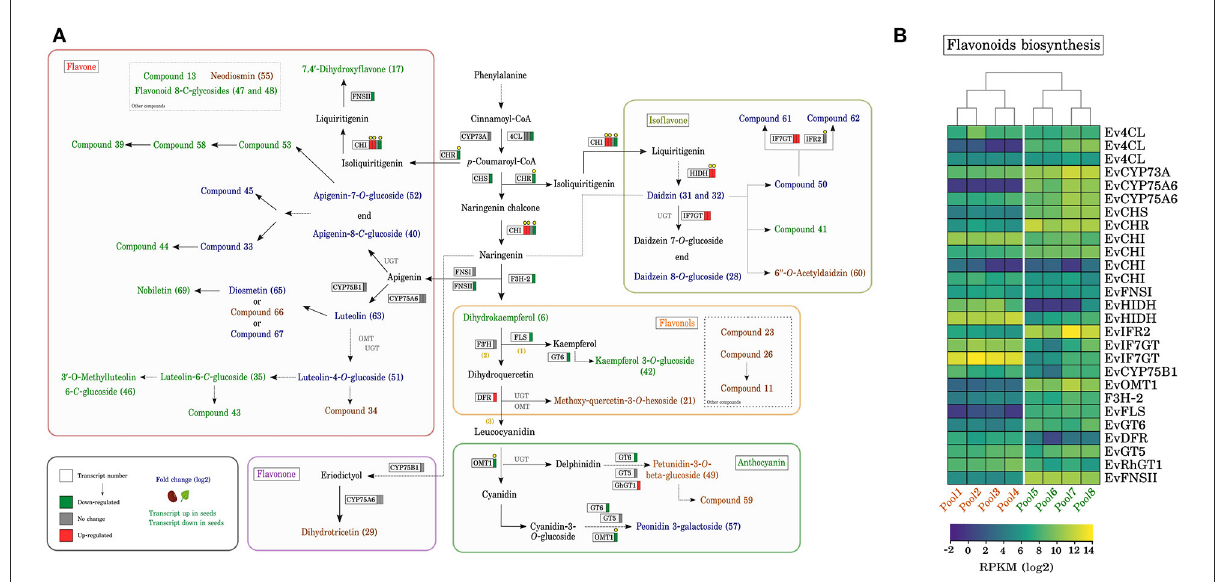
FIGURE5 Flavonoids biosynthesis pathway in Erythrina velutina . (A) Proposed flavonoid pathway in E. velutina . Each frame corresponds to an identified transcript, with red and green bars indicating up- and down-regulated, respectively, while gray bars indicate no change. Flavonoids written in blue were annotated in both plant structures, while the shown in orange and green represent those found only in seeds or leaves, respectively. Transcripts marked with yellow circles are those with identified protein matches, with significant NIAF. (B) Expression pattern of candidates for the biosynthesis pathway of different classes of flavonoids. Pools from 1 to 4 represent biological replicates of seeds, while pools from 5 to 8 represent different replicates of leaves. The color scale shows the fold change value in RPKM. Ev4CL , 4-Coumarate–Coa ligase; EvCYP73A , Trans-cinnamate 4-monooxygenase; EvCHS , Chalcone synthase; EvCHR , Chalcone reductase; EvFNSI , Flavone synthase 1; EvHIDH , 2-Hydroxyisoflavanone dehydratase; EvIF7GT , Isoflavone 7-O-glucosyltransferase; EvIFR2 , Isoflavone reductase; EvCHI , Chalcone isomerase; EvF3H-2 , Flavanone 3-dioxygenase 2; EvFNSII , Flavone synthase 2; EvCYP75B1 , Flavonoid 3’-monooxygenase; EvFLS , Flavonol synthase; EvGT6 , UDP-glucose flavonoid 3-O-glucosyltransferase 6; EvDFR , Dihydroflavonol 4-reductase/Flavanone 4-reductase; EvGT5 , Anthocyanidin 3-O-glucosyltransferase 5; EvRHGT1 , Anthocyanidin 5,3-O-glucosyltransferase; EvOMT1 , Flavonoid 3’-O-methyltransferase; EvCYP75A6 , Flavonoid